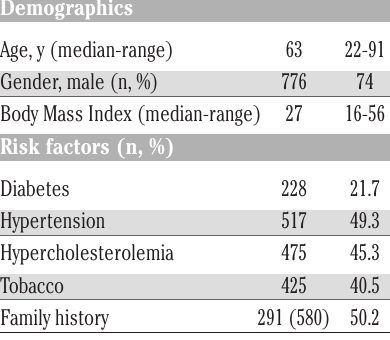
Table 1. Characteristics of the entire popu- lation